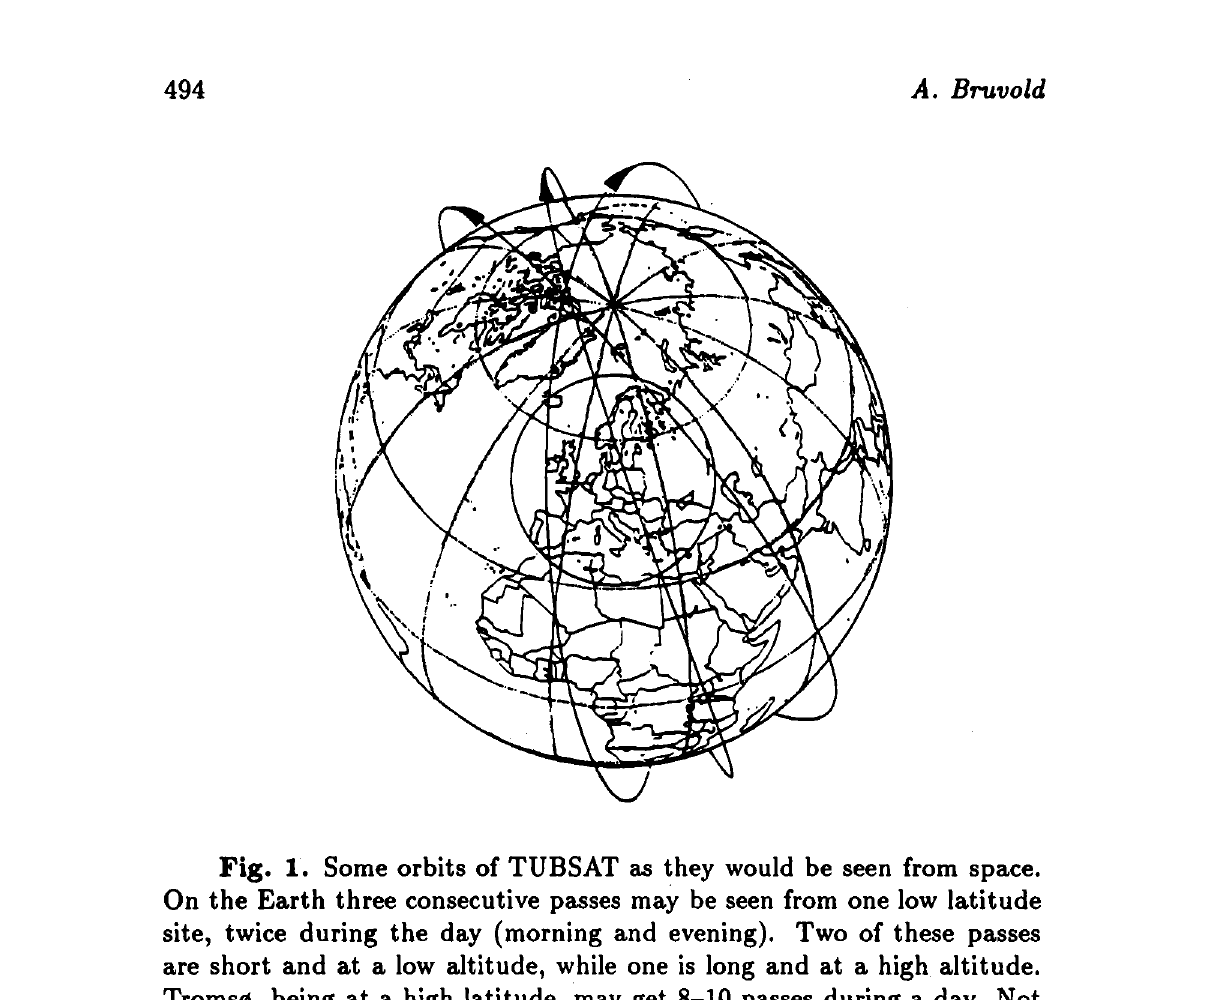
Fig. 1. Some orbits of TUBSAT as they would be seen from